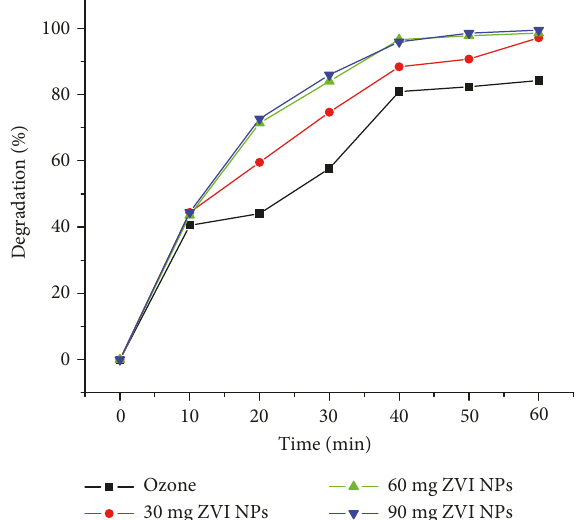
Figure 4: Percentage of degradation of phenolphthalein with di ff erent doses of ZVI